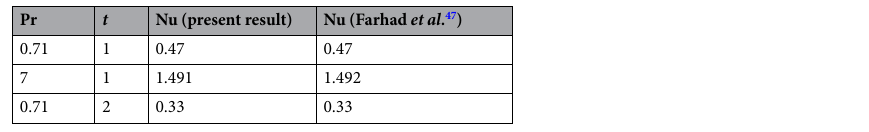
Table 4. Nusselt number Nu (the measure of rate of heat transfer) for the present problem and its comparison with published results of Farhad et al . 47 for regular fluid ( φ = 0).